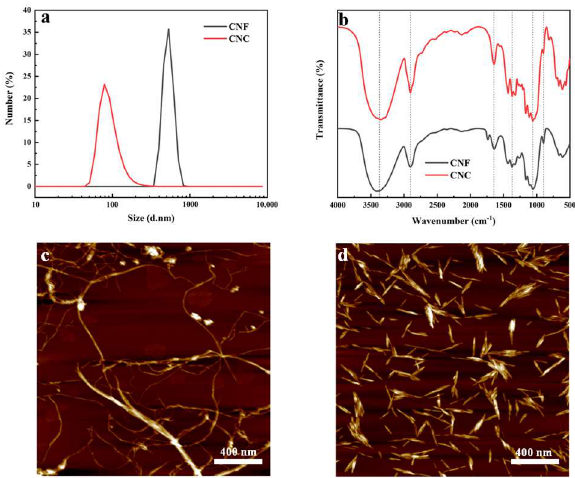
Figure 1. ( a ) Particle size distribution of CNF and CNC, ( b ) infrared spectra of CNF and CNC after freeze-drying, ( c ) AFM image of CNF and ( d ) AFM image of